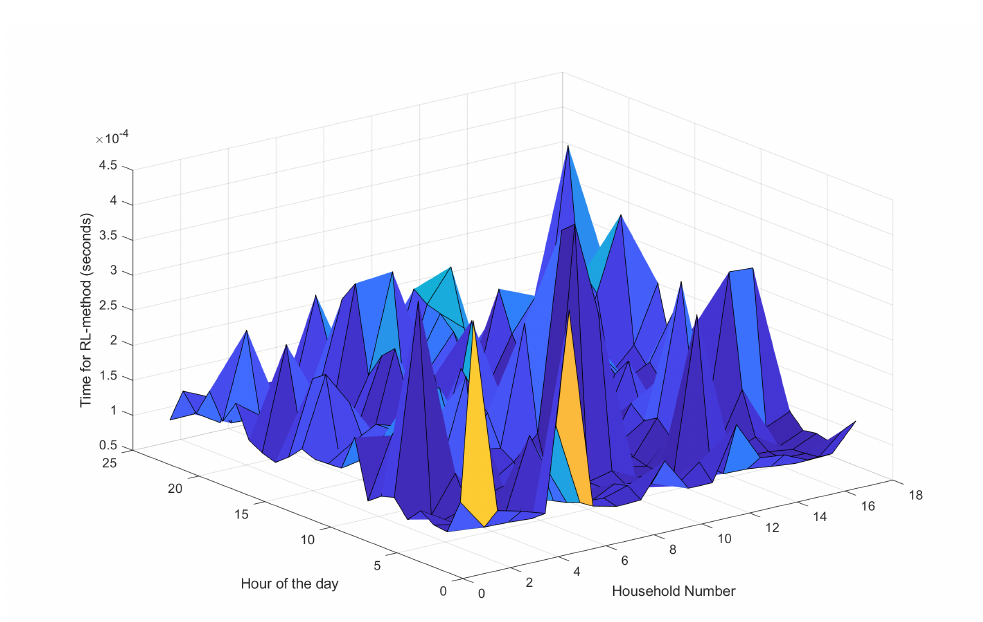
Figure 12. The average duration for each household to complete the hourly RL routine averaged over 30